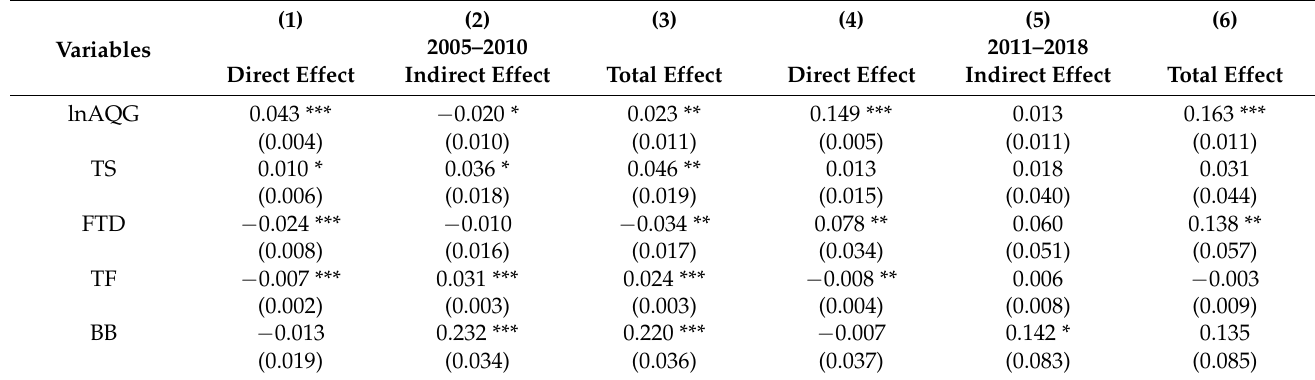
Table 8. Decomposition effect of different